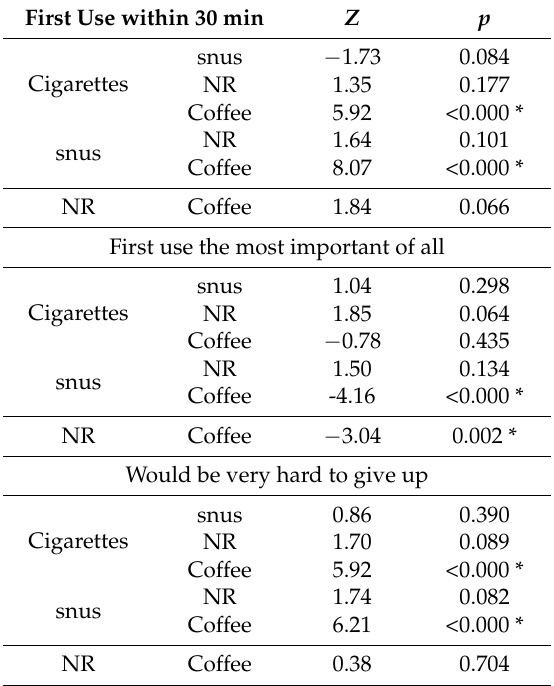
Table 3. Test of proportions among indicators of dependence. Z statistics and associated p